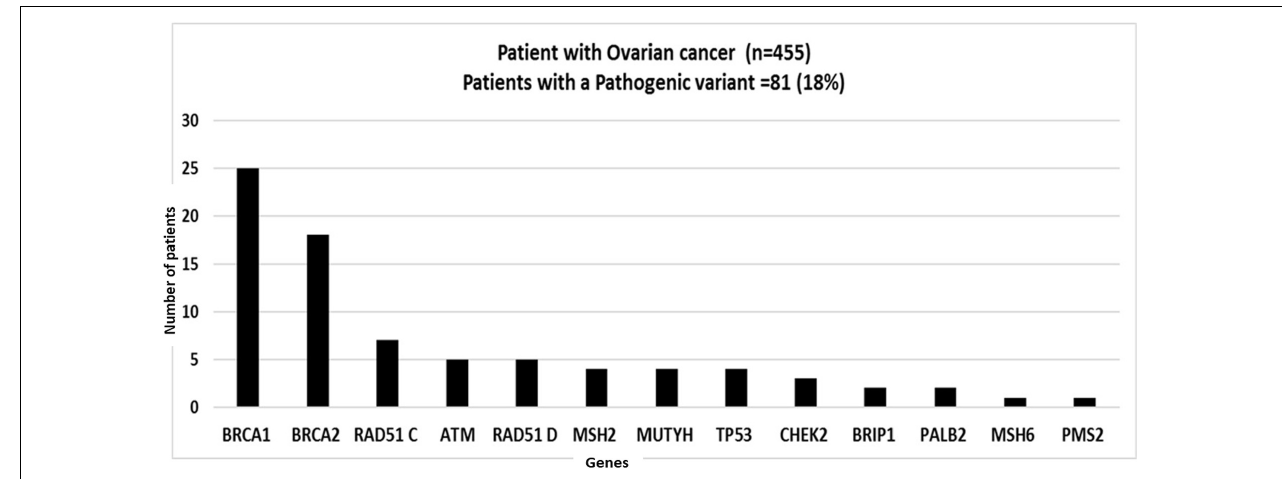
FIGURE 4 | Graph showing distribution of pathogenic variants (PVs) in patients with ovarian cancer: Patients presenting with Ovarian cancer ( n = 455). 18%(82/455) patients tested positive for a PV. Genes with PVs are listed on the X -axis; Number of patients positive for a pathogenic variant is shown on Y